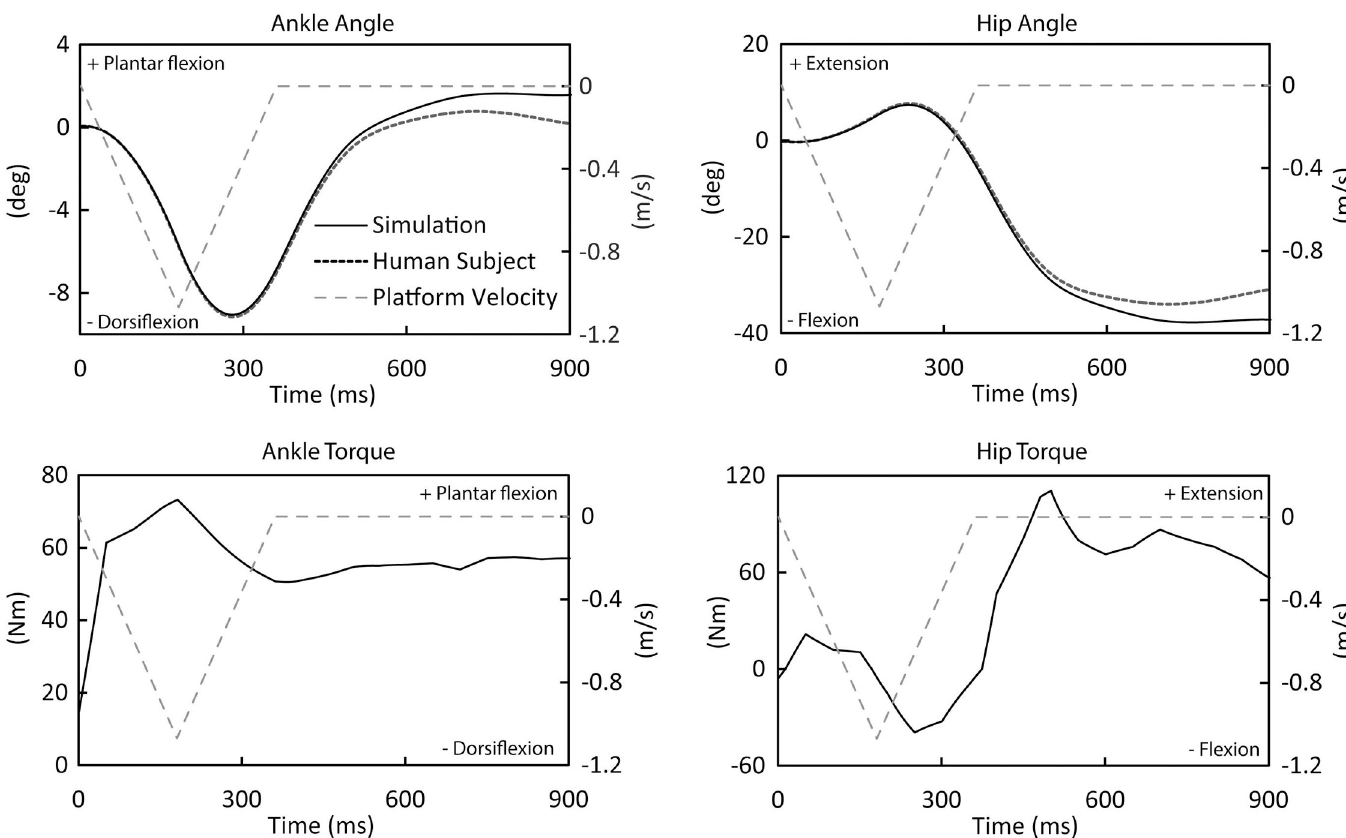
Fig 5. Joint angles, torques, and platform velocity (secondary y -axis) during the trial at maximal platform displacement of the young model. These results illustrate the general pattern of these variables over time during simulations, and similarities between ankle and hip angles between the simulations and human subjects